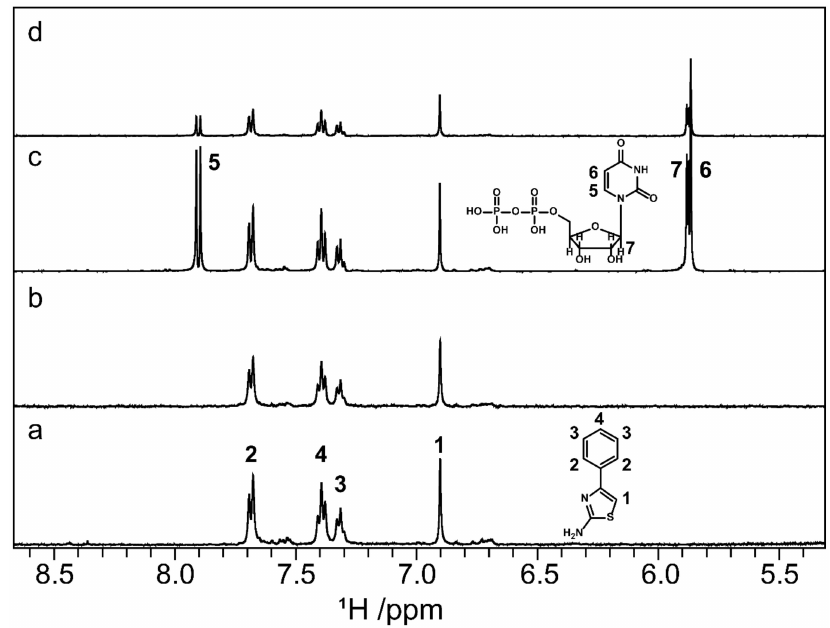
Figure 9. STD NMR spectra of ligand A4 and WaaG carried out with and without UDP as a competitor. In sequence from the bottom to the top, 1D 1 H STD off-resonance ( a ) and on-resonance ( b ) irradiation of WaaG in the presence of A4 and off-resonance ( c ) and on-resonance ( d ) irradiation with UDP added to the protein-ligand mixture. Compound A4 shows interaction with WaaG also in the presence of